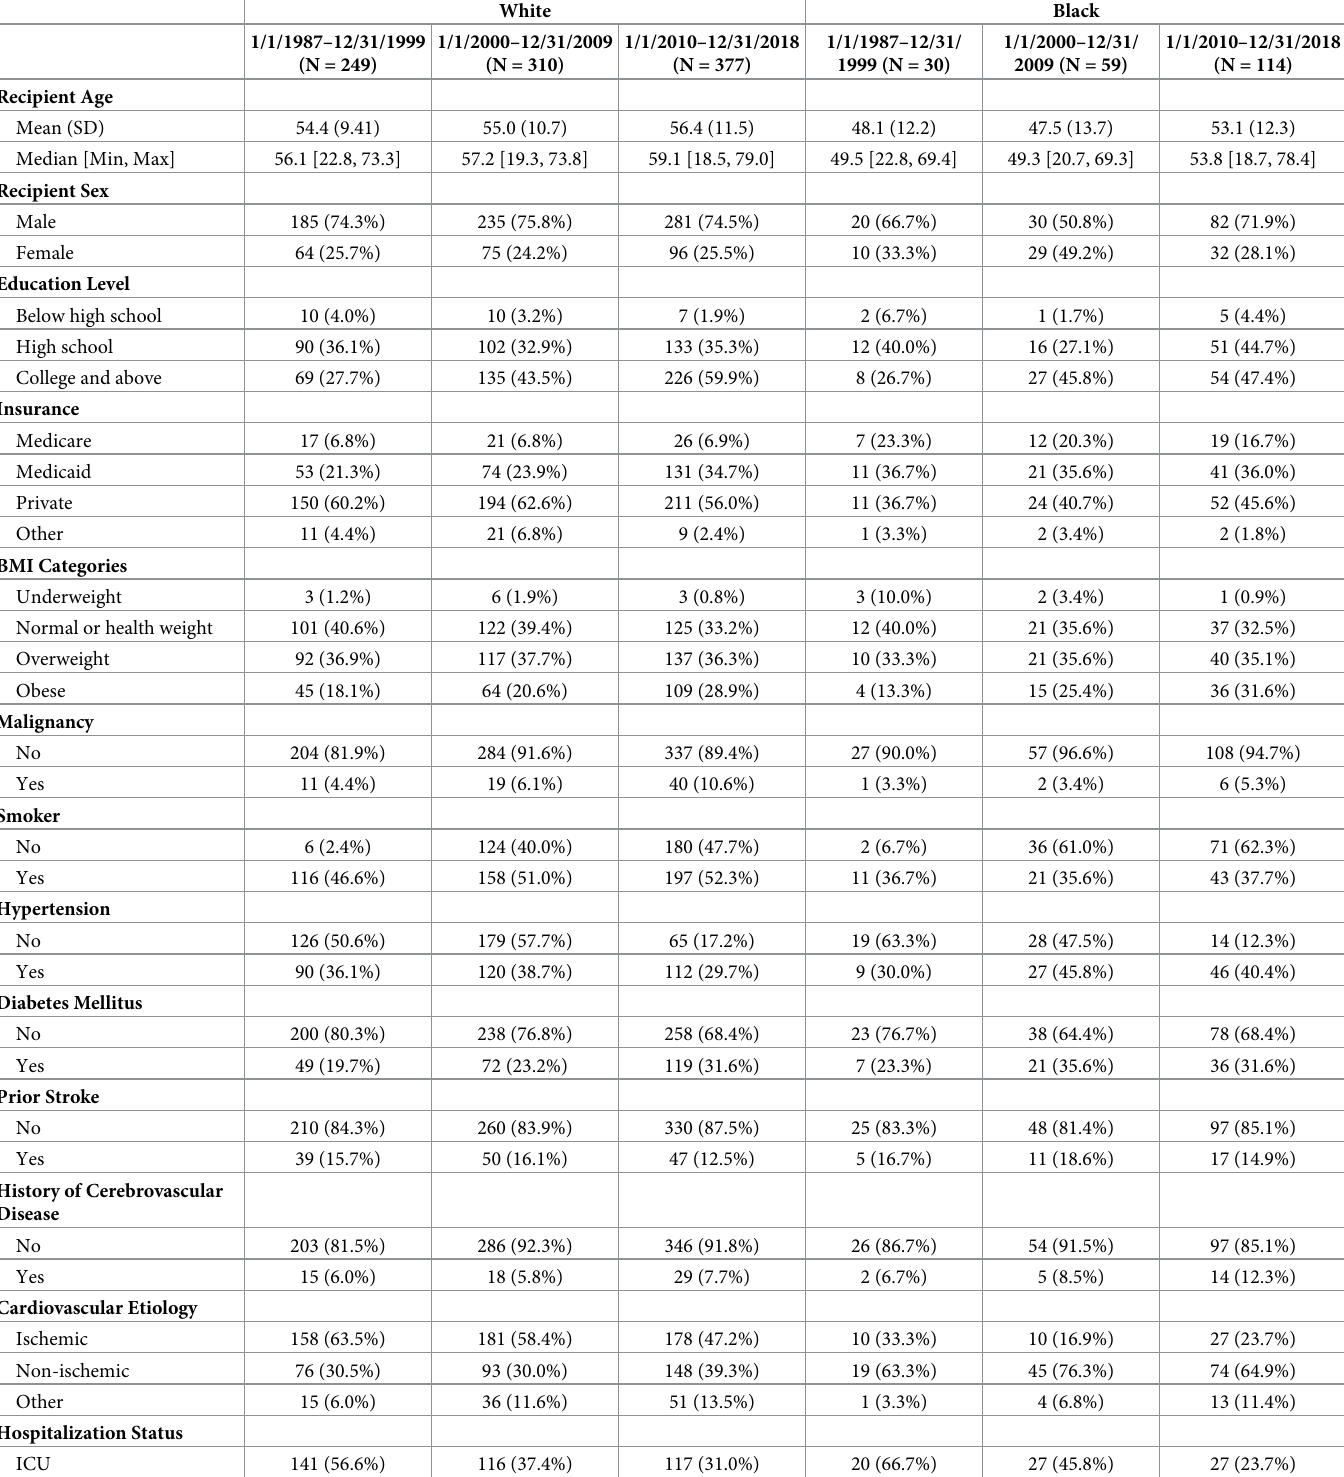
Table 2. Heart transplant recipient characteristics by race and transplant era for post-transplant stroke survivors, Scientific Registry of Transplant Recipients (SRTR), January 1, 1987 to December 31, 2018; n (%) unless otherwise